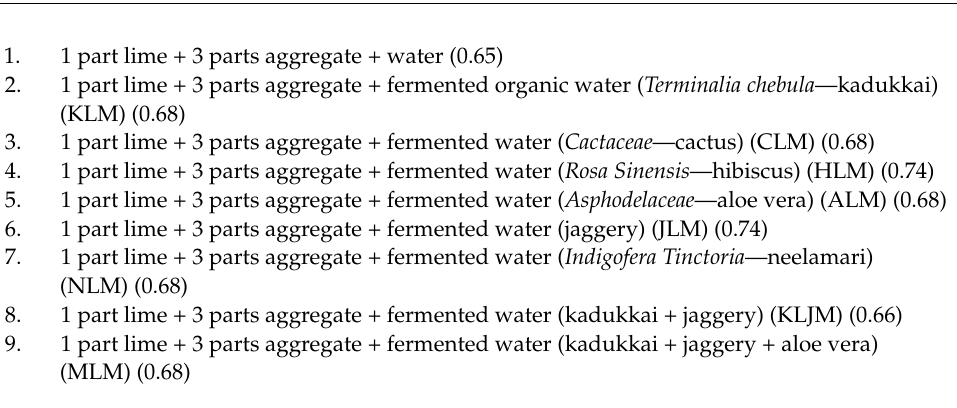
Algorithm 1. Description of the lime mortar mix